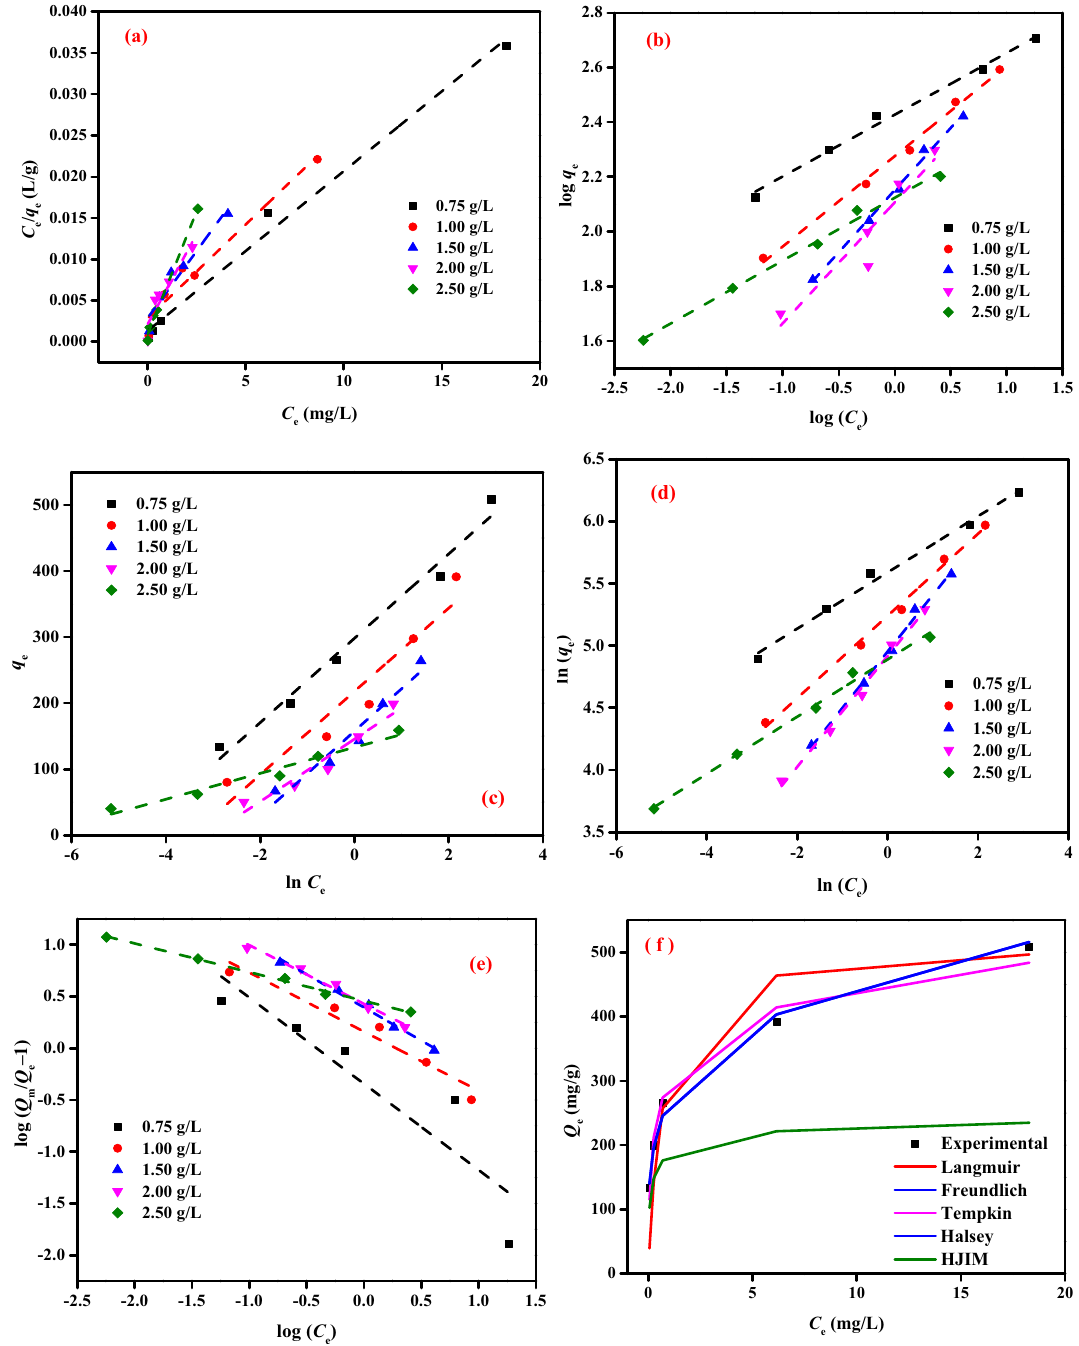
Figure 10. ( a ) LIM, ( b ) FIM, ( c ) TIM, ( d ) HIM, ( e ) GIM profiles for C 0 of AY11 dye (100–400 mg/L) on PPAC doses (0.75–2.5 g/L) at 25 ± 2 °C, ( f ) Comparison of the experimental and predicted isotherm profiles for the dye AY11 at a PPAC dose of 0.75 g/L and C 0 (100–400